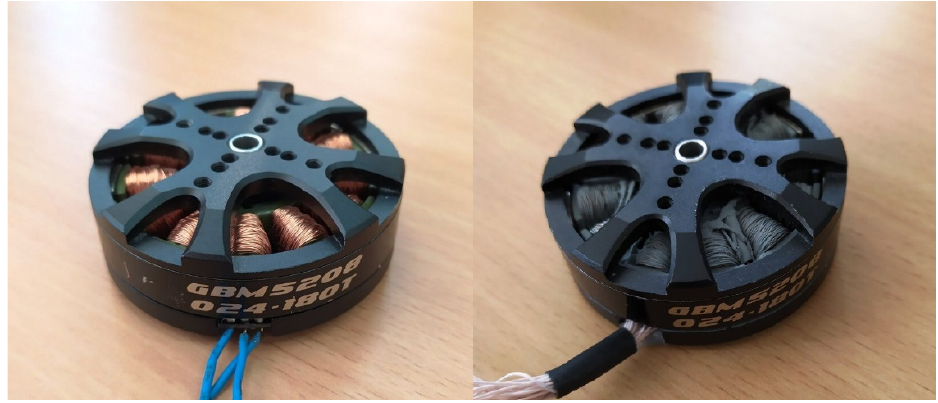
Figure 4. Original and modified motors GBM5208—original (left) and modified (right) .